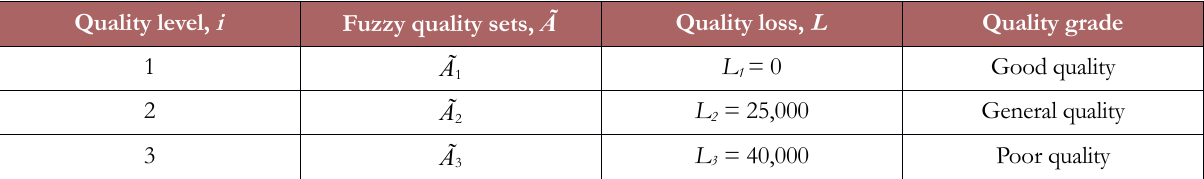
Table 1. Fuzzy quality sets and quality